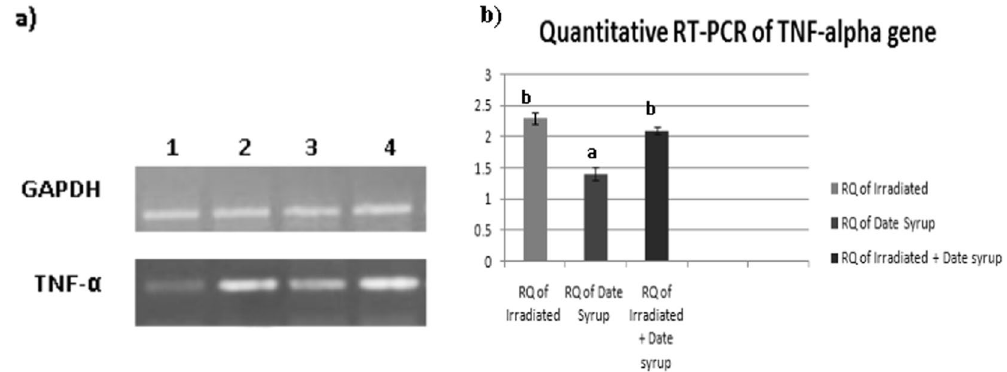
Figure 3. Relative quantitative expression (RQ) of TNF- α gene in liver of different groups. ( a ) Cropped gels identify the electrophoretic mobility of quantitative RT-PCR products of TNF- α and GAPDH (internal control) genes on two separate 2% agarose gels. Lane: 1 = control; lane 2 = Irradiated animal; lane 3 = Date syrup animal; lane 4 = Irradiated + Date syrup animal. ( b ) Evaluation of TNF- α gene expression in different groups. Real-Time PCR analysis was used to determine mRNA levels of TNF- α gene. The data were normalized to an endogenous reference, GAPDH and expressed as relative to control. Values are presented as mean ± SE. Means above column of histogram with different letter (a–b) are significantly different at (P < 0.05).